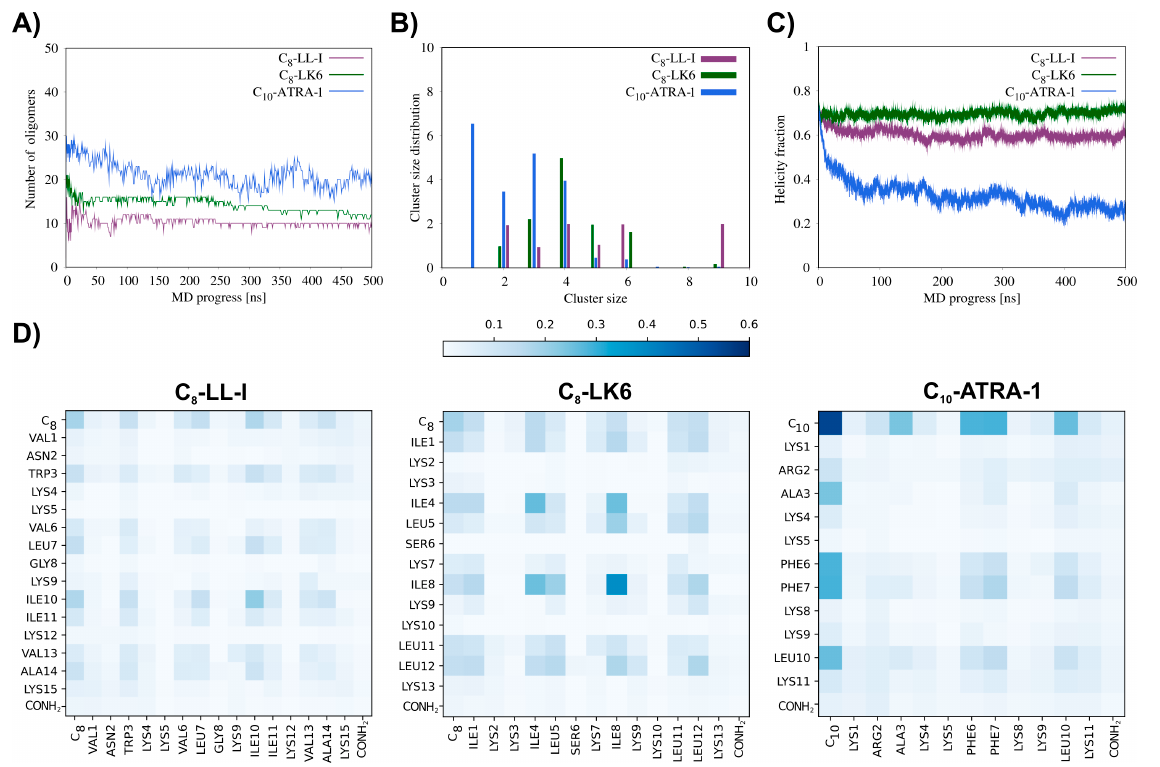
Figure 5. Analysis of the 500 ns MD simulations following the aggregation of the three representative lipopeptides, C 8 -LL-I, C 8 -LK6 and C 10 -ATRA-1. ( A ) The number of oligomers over the MD simulation time. ( B ) The cluster size distributions over the last 50 ns of the MD simulations. ( C ) The overall helicity over the MD simulation time. ( D ) The inter-residue contact map with probabilities according to the color scale. Contacts were determined between all the peptides in the 50-molecule system in the last 50 ns of the 500 ns MD simulations.